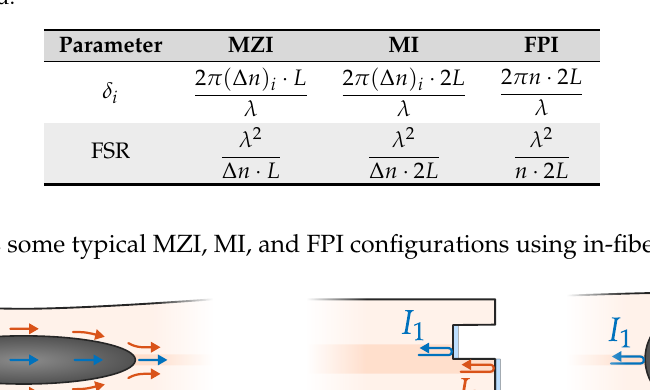
Table 4. Typical phase delay ( δ i ) and Free Spectral Range (FSR) depending on the interferometer configuration used.